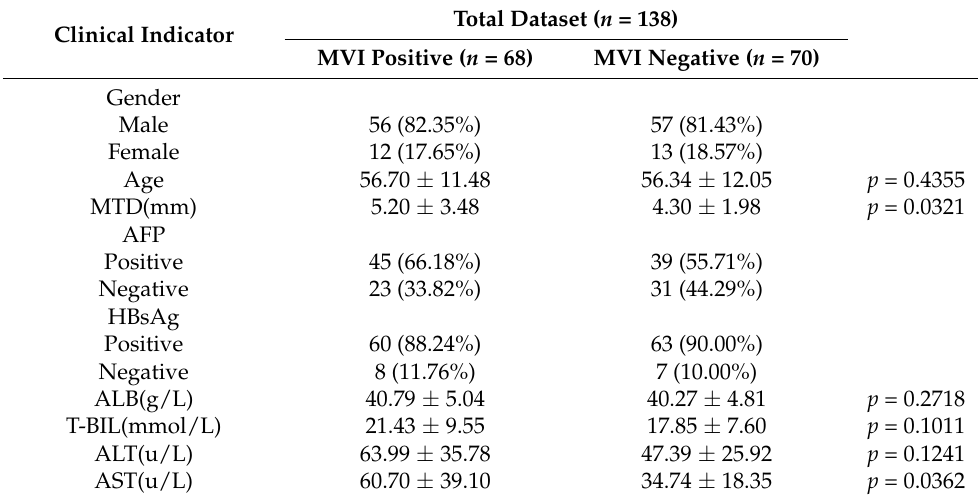
Table 1. Statistics of clinical indicators of datasets employed in the